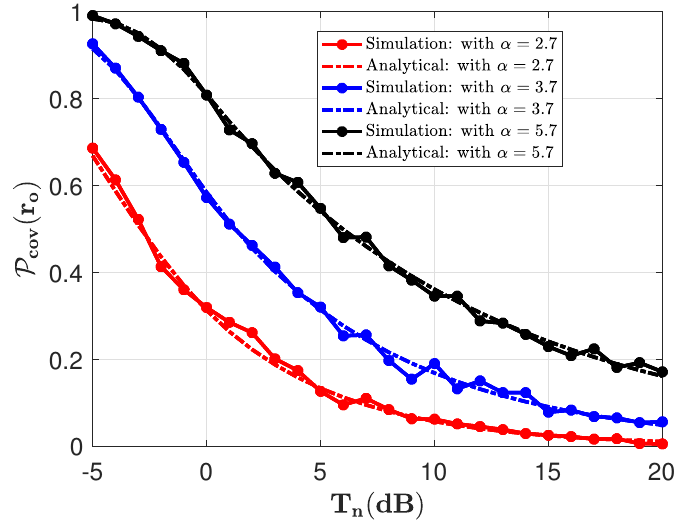
Figure 5. Probability of coverage with SIR comparing cases of pathloss exponent. Table 3. Table of simulation Parameters for the Heterogeneous